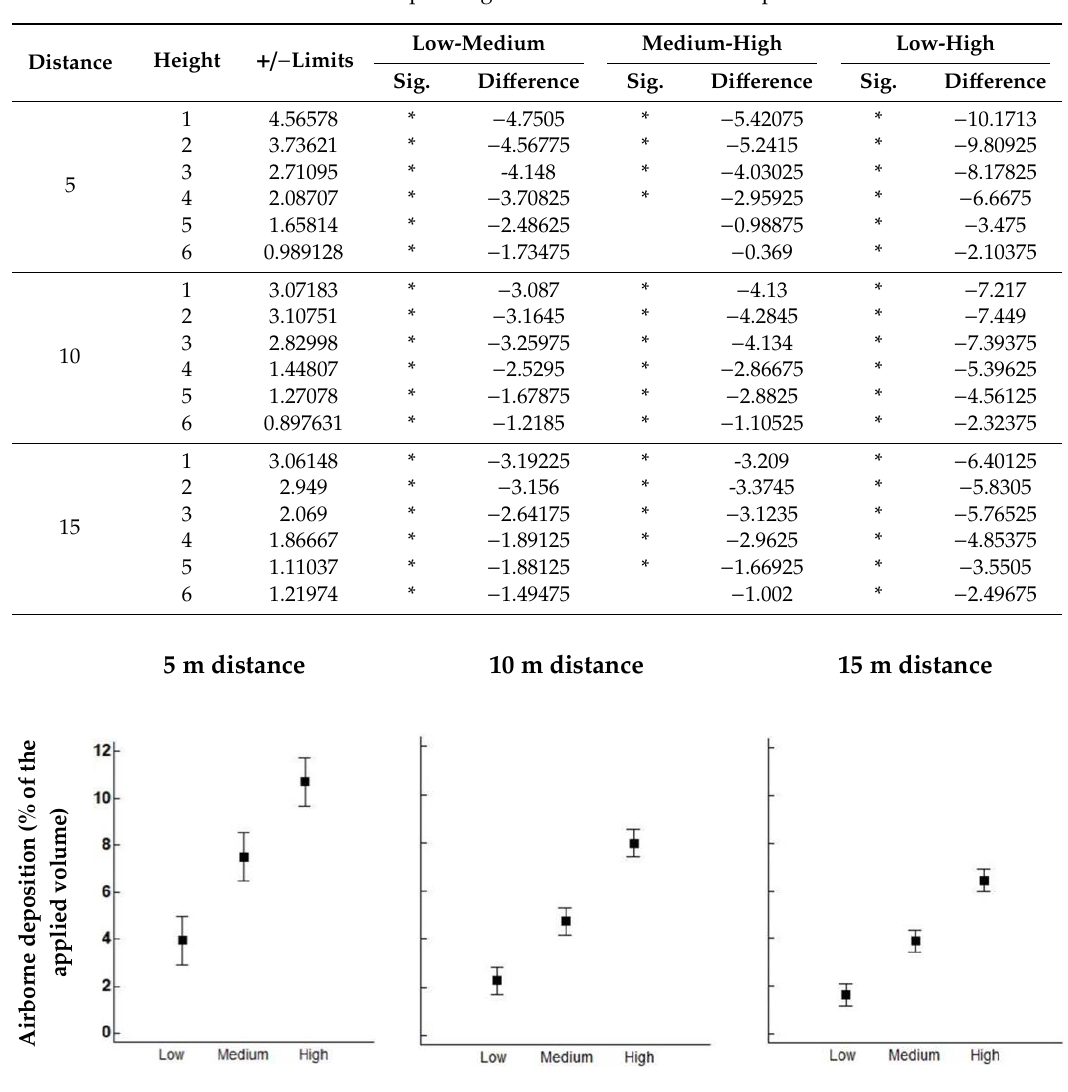
Table 10. Multiple-range LSD tests for vertical samplers.